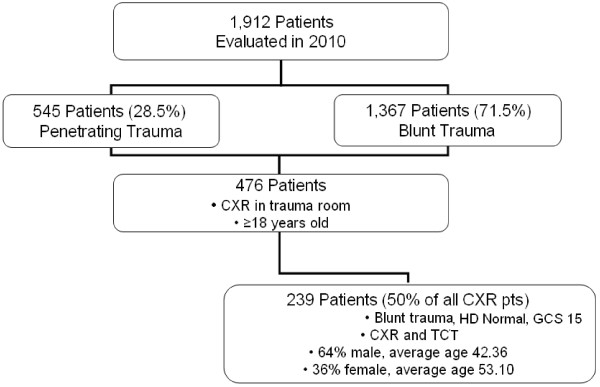
Patient Selection.